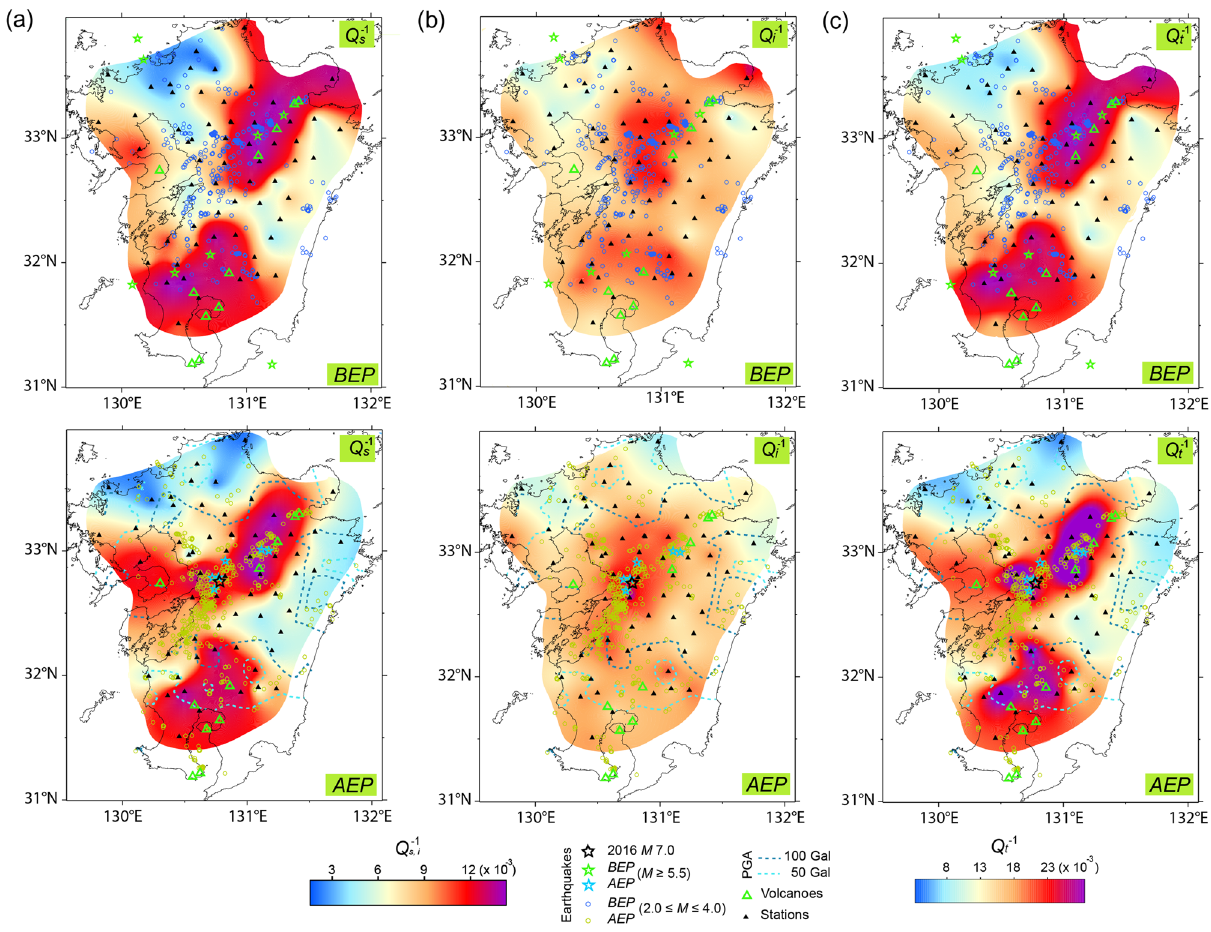
Figure 2. Map of the ( a ) Q s –1 , ( b ) Q i –1 , and ( c ) Q t –1 value at 1.5 Hz in the BEP (top) and AEP (bottom) for the Kumamoto earthquake ( M 7.0). Earthquakes ( M ≥ 5.5) and analyzed events (2.0 ≤ M ≤ 4.0) were classified based on the BEP and AEP . In the AEP , blue and sky-blue dotted lines represent a PGA of 100 and 50 Gal (shown in Fig. 1), respectively. Stations ( ▲ ) and volcanoes ( △ ) are displayed for both periods.